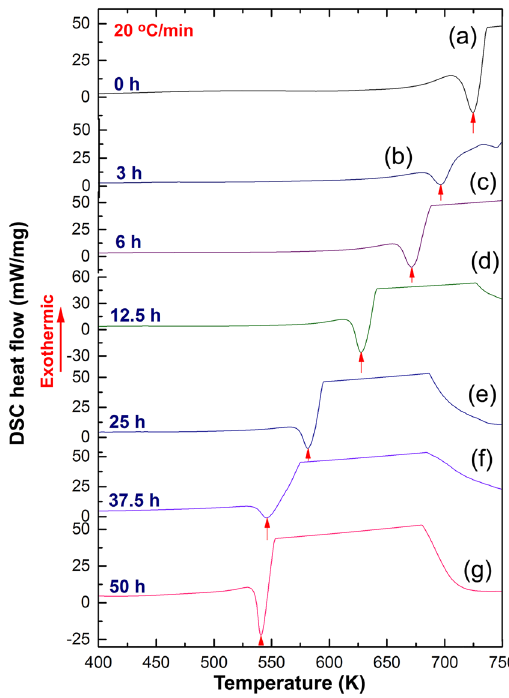
Figure 3. Effect of RBM time on the thermal stability of MgH 2 /5 wt.% TiMn 2 powders obtained after selected RBM time. DSC curves of MgH 2 powder obtained after 200 h of RBM time and then mechanically doped with 5 wt.% TiMn 2 powder for ( a ) 0 h, ( b ) 3 h, ( c ) 6 h, ( d ) 12.5 h, ( e ) 25 h, ( f ) 37.5 h, and ( g ) 50